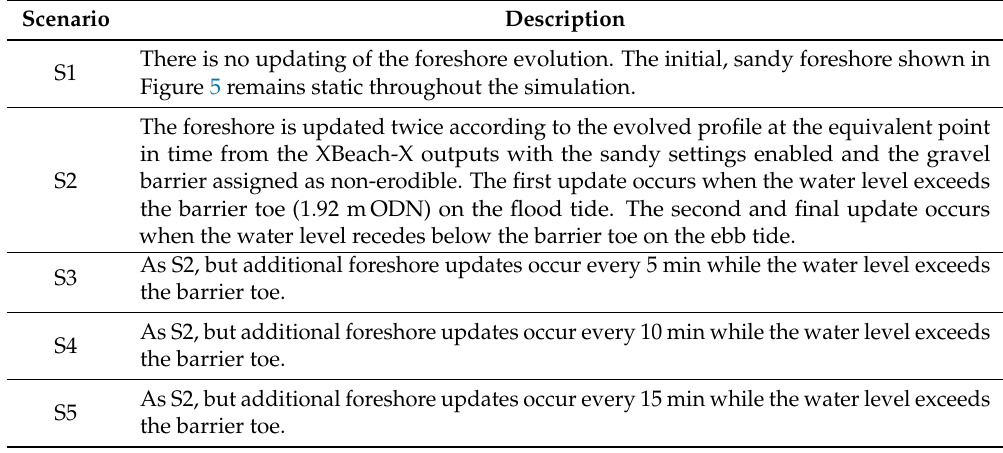
Table 3. The five applied foreshore evolution scenarios in the XBeach-X gravel simulations. Scenario